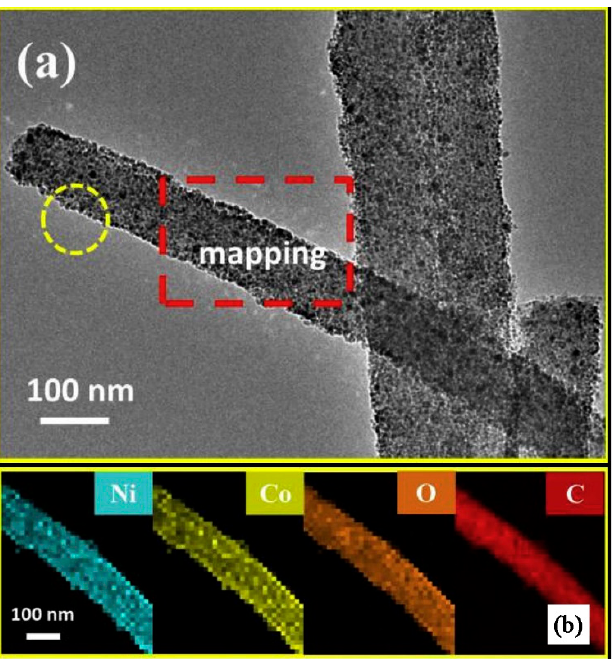
Figure 7. ( a ) TEM image and ( b ) elemental mappings of Ni, Co, O, and C for carbon/NiCo 2 O 4 . Reproduced with permission from [95]. Copyright 2019, Elsevier.